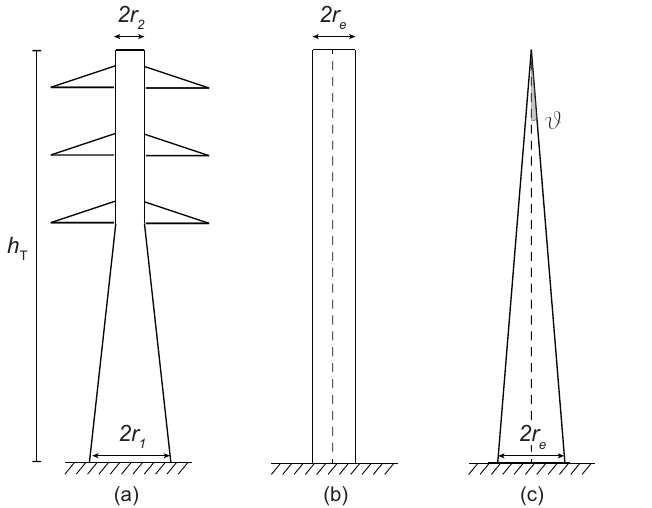
Figure 5. Different equivalent structures considered for the tower under study; ( a ) Tower under study; ( b ) Approximated cylindrical equivalent tower; ( c ) Approximated conical equivalent